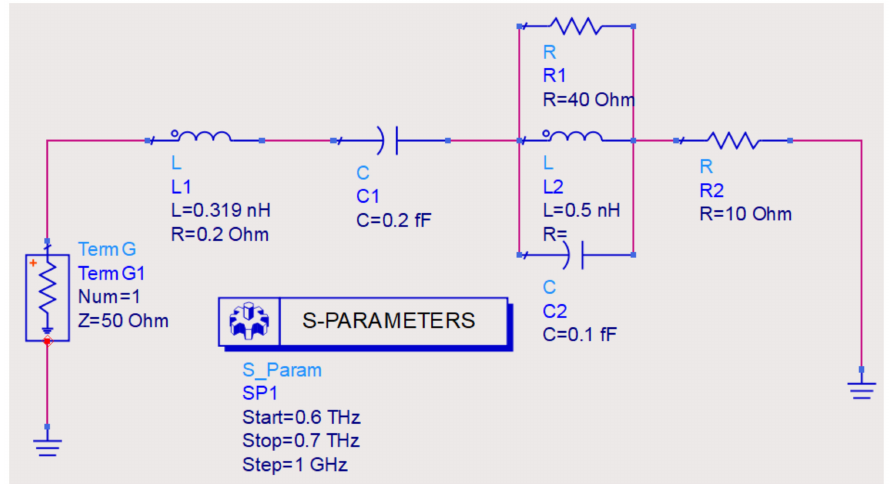
Figure 8. Equivalent circuit model for the proposed antenna design.